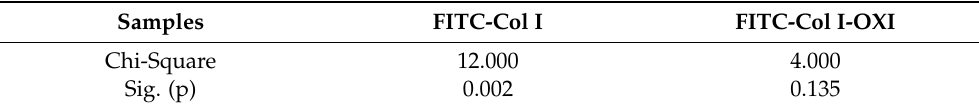
Table 1. Chi-Square and statistical significance of the relative changes in the fluorescence intensity ( ∆ RPU) upon collagenolytic action of collagenase CH on FITC-Col and oxidized FITC-Col I-OXI according to the Friedman test